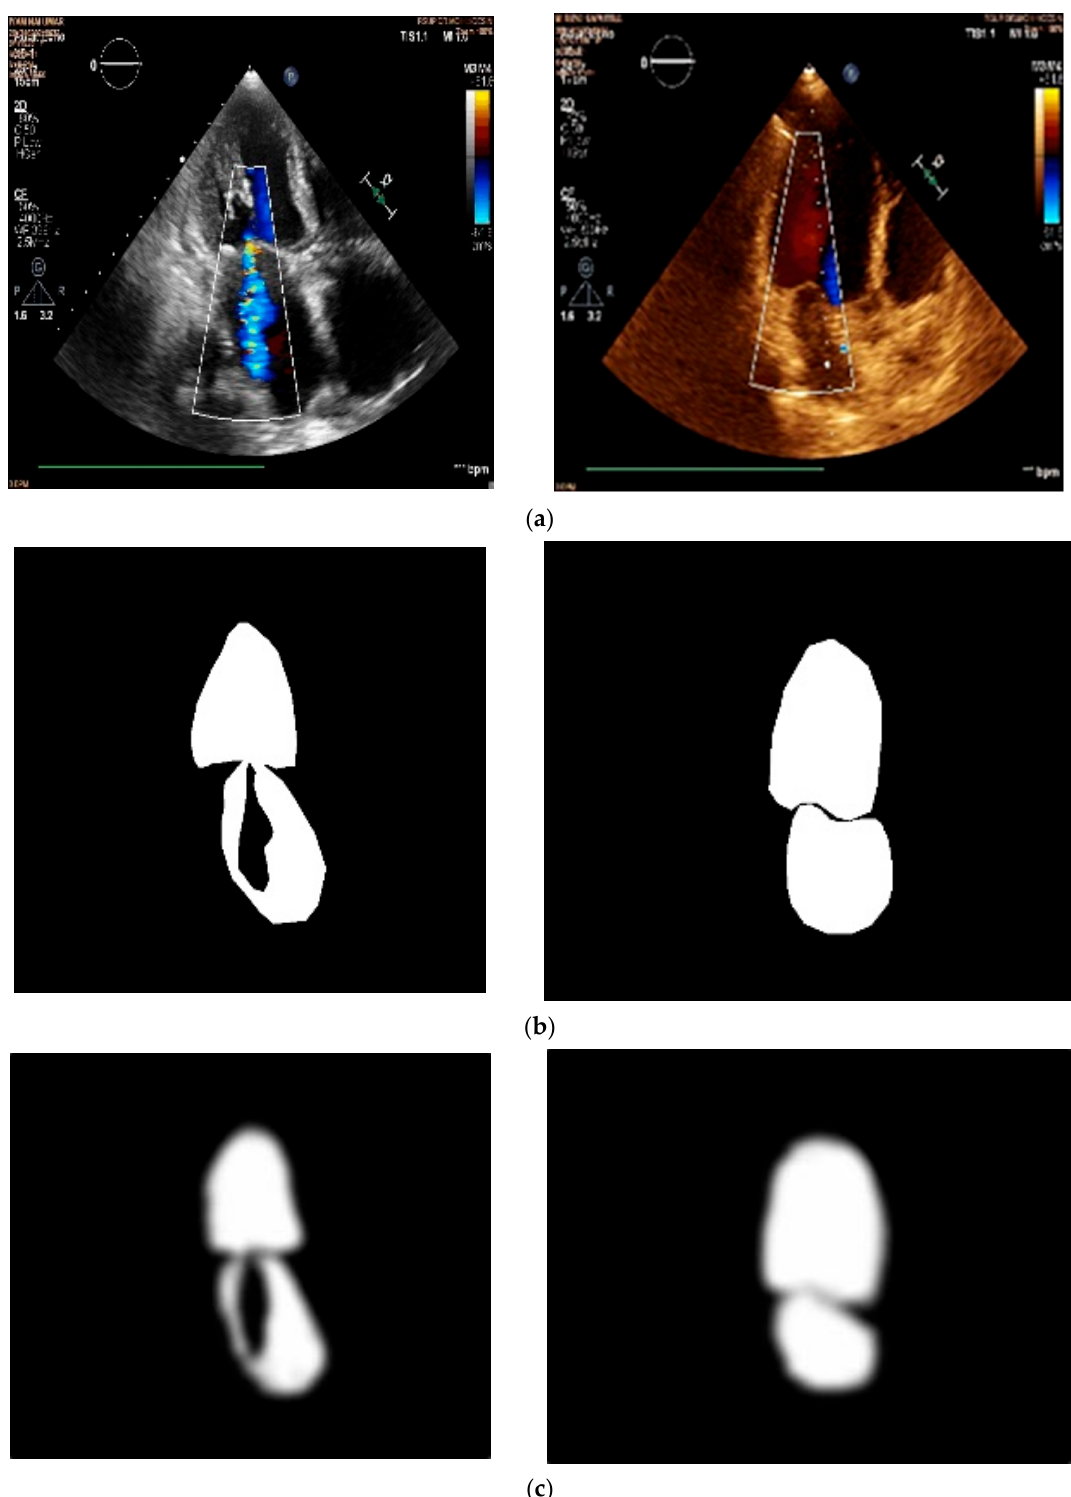
Figure 5. Comparation from ( a ) Raw Image; ( b ) Ground Truth; ( c ) Predicted frame from U-Net3 with 500 epochs;